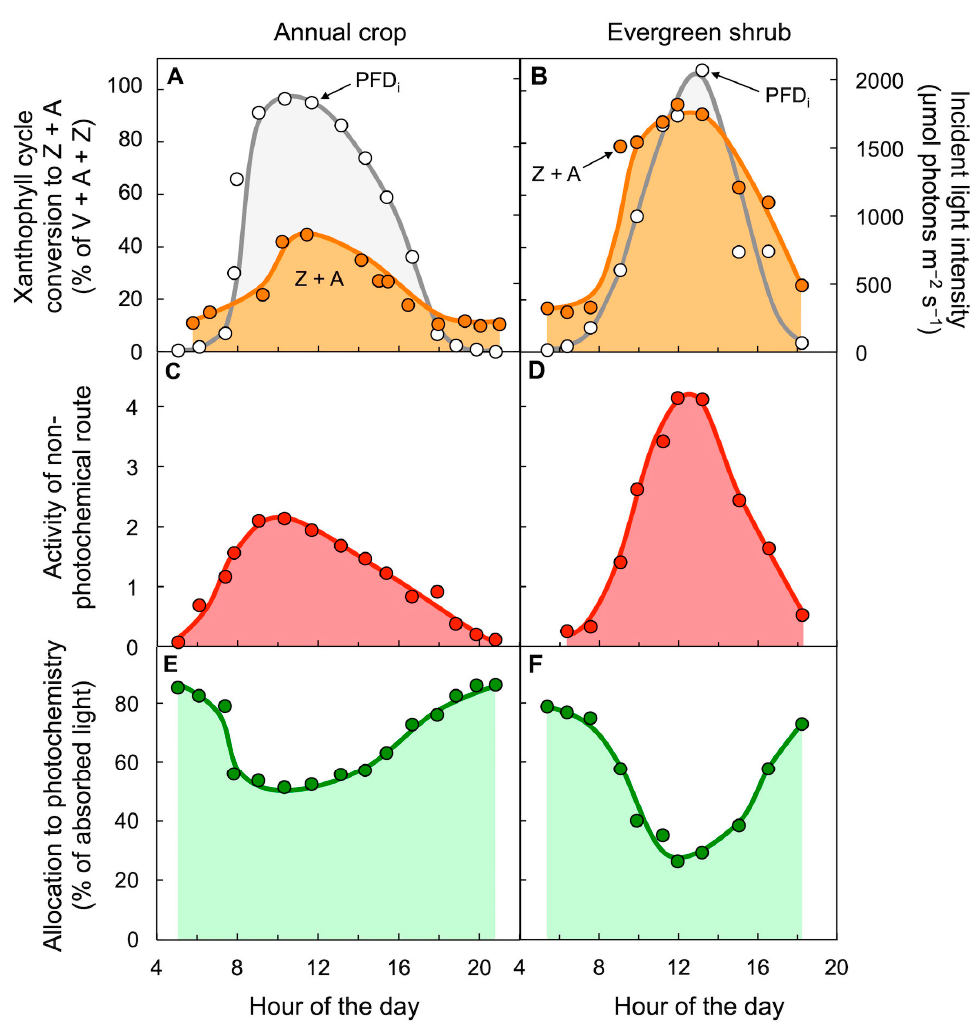
Figure 7. Diurnal characterization of ( A , B ) light incident on the upper leaf surface (PFD i ) and percent of the xanthophyll cycle present as zeaxanthin and antheraxanthin (Z + A), ( C , D ) dissipation of excitation energy as thermal energy via a regulated non-photochemical route (quantified from chlorophyll fluorescence as Stern–Volmer quenching), and ( E , F ) percentage of absorbed photons allocated to photochemistry (quantified from chlorophyll fluorescence as photosystem II efficiency) in leaves of the herbaceous annual sunflower ( A , C , E ) and the woody evergreen Euonymus kiautschovicus ( B , D , F ) on summer days. V = violaxanthin. Data for sunflower are from Demmig-Adams and Adams [48] and Demmig-Adams et al. [49]. Data for E. kiautschovicus are from Verhoeven et al. [50].